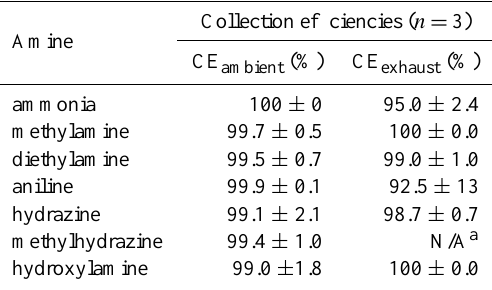
Table 4. Collection Efficiencies, Measured in N 2 (CE ambient ) and in Undiluted Vehicle Exhaust (CE exhaust ) , for Volatile Bases by Midget Impingers.